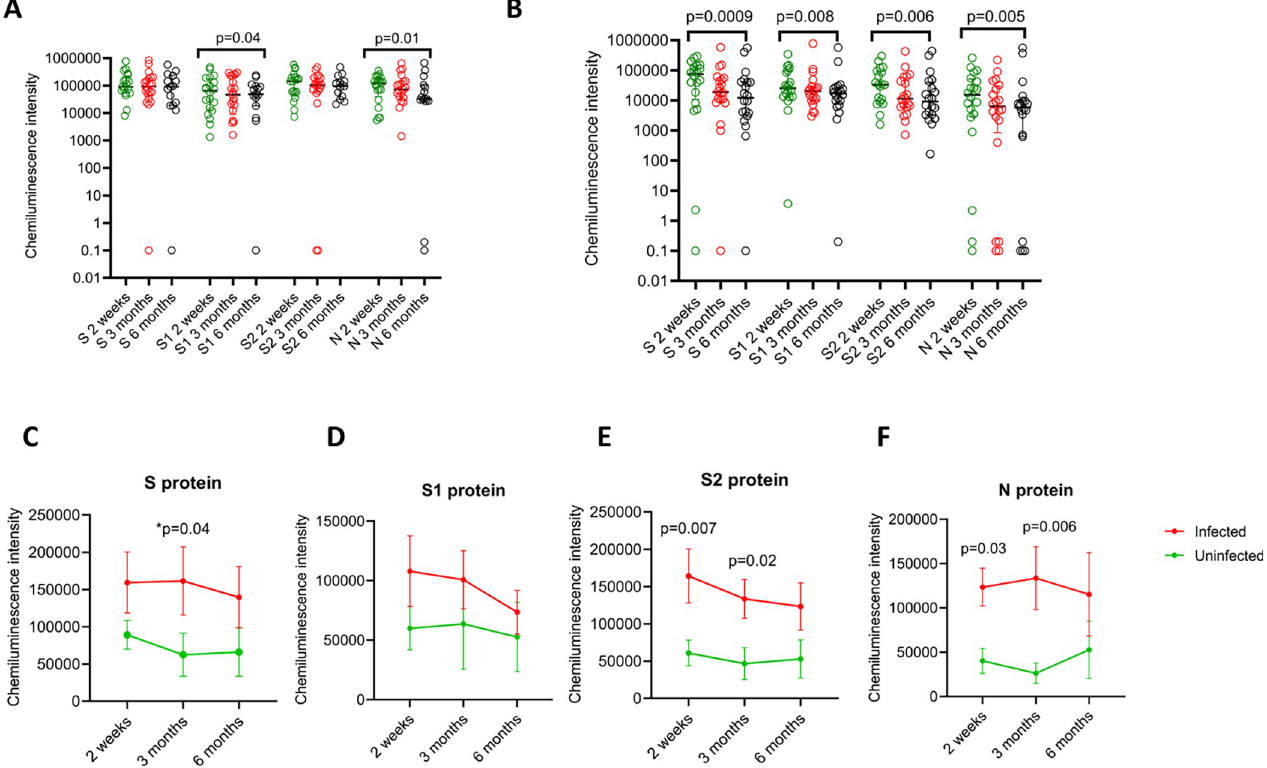
Fig 1. Kinetics of IgG antibody responses to different SARS-CoV-2 proteins in previously infected and uninfected individuals who received the Sinopharm/BBIBP-CorV vaccine. IgG antibodies to SARS-CoV-2 spike (S), S1 subunit (S1), S2 subunit (S2) and nucleocapsid (N) at 2 weeks, 3 months and 6 months post second dose, were measured in those who were naturally infected (n = 20) and na ï ve individuals (n = 20) using the Peggy Sue platform. The IgG responses the different proteins were compared over time in previously infected (A) and uninfected (B) individuals. The changes in responses to S (C), S1 (D), S2 (E) and N (F) was also compared in infected and uninfected individuals over time. The Friedman test was used to compare the IgG levels between different time points for different proteins in infected and uninfected individuals. The Holm-Sidak method was used to compare the differences in IgG levels for different proteins and different time points in those who were infected and uninfected. All tests were two-tailed.